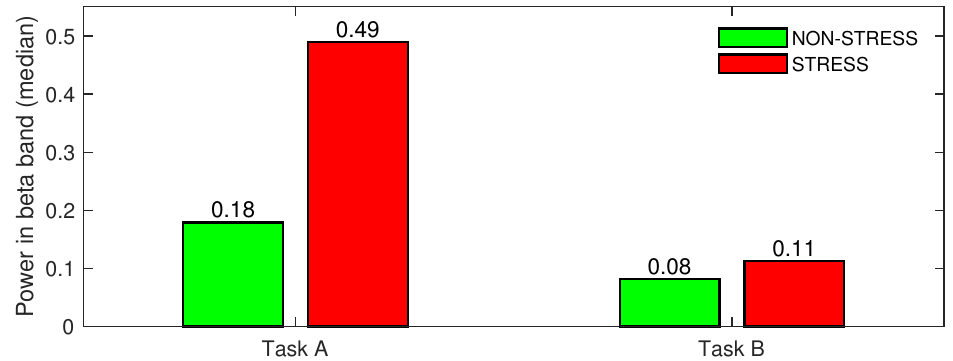
Figure 4. STRESS vs. NON-STRESS condition—difference in medians for Task A and Task